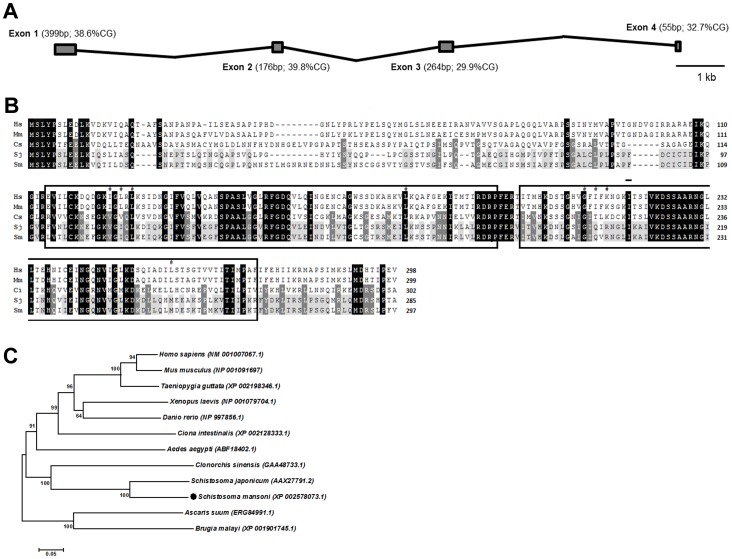
Bioinformatic analysis of Schistosoma mansoni syntenin (SmSynt).(A) Schematic representation of the S. mansoni syntenin gene. The SmSynt gene (Smp_068530) has 4 exons, indicated by grey rectangles, the length of each exon and its GC content are indicated in parentheses. (B) Alignment of the protein sequences of syntenin homologs from human, mouse and trematode species using ClustalX 2.0. Black background indicates identity in all variants, dark grey indicates identity in trematodes, light grey indicates identity in schistosomes, white background indicates a non-conservative residue, dashes indicate gaps introduced to facilitate alignment. The two conserved PDZ domains are contained within black boxes as defined by ScanProsite online software. (#) indicates the residues forming the hydrophobic pockets of PDZ domains [19]. GenBank Accession Numbers: Hs, Homo sapiens (NM_001007067.1); Mm, Mus musculus (NP_001091697); Cs, Clonorchis sinensis (GAA48733.1); Sj, Schistosoma japonicum (AAX27791.2) and Sm, Schistosoma mansoni (XP_002578073.1). (C) Phylogenetic tree of SmSynt and homologs from other species generated using the Neighbor-Joining method. Bootstrap (1000 replicates) percentages are indicated at each branch. The tree is drawn to scale with branch lengths in nucleotide substitutions per site, the same units used to infer the phylogenetic tree. Analyses were conducted in MEGA6. GenBank accession numbers are given in parentheses.